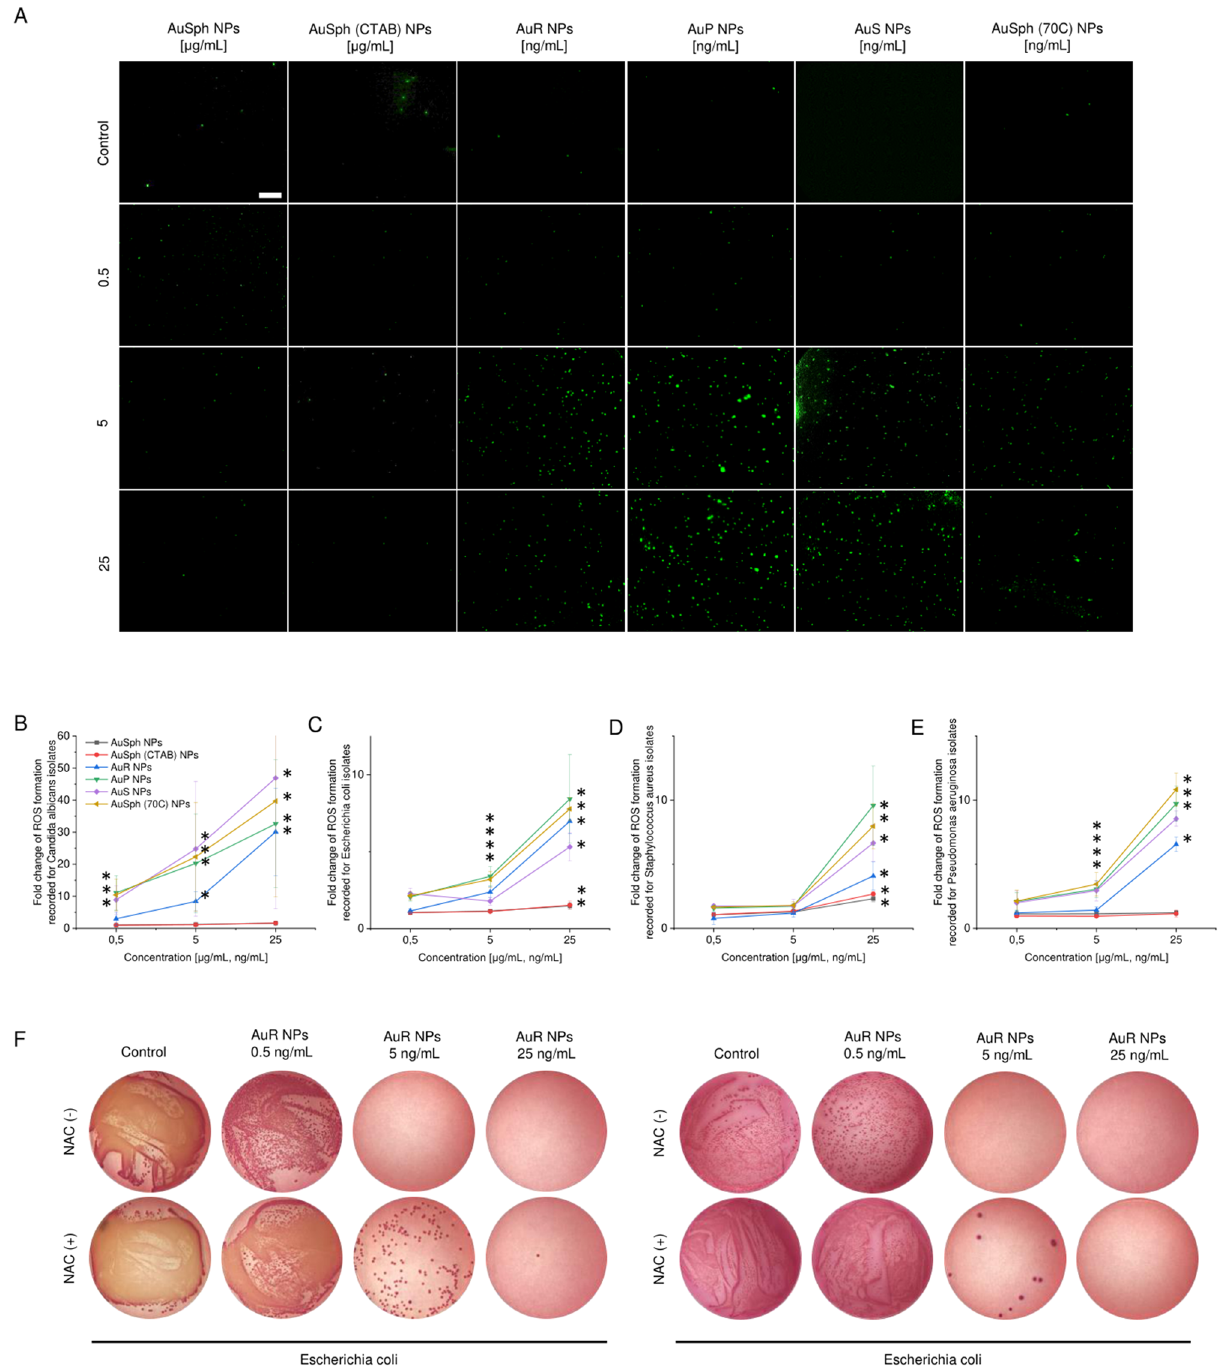
Figure 4. Generation of reactive oxygen species (ROS) in fungi and bacteria subjected to varied-shaped gold nanoparticles over an 1 h incubation. Increase of ROS-positive E. coli cells investigated using fluorescence microscopy ( A ). Scale bar ~ 20 µm. Rise in ROS-derived fluorescence signal recorded for C. albicans ( B ), E. coli ( C ), P. aeruginosa ( D ) and S. aureus isolates ( E ). Photographs of representative MacConkey agar plates with E. coli treated with AuR NPs at the indicated concentrations with or without pre-treatment with NAC for 1 h. ( F ). *Indicates statistical significance ( p < 0.05) when compared to untreated bacteria. For ( B )–( E ) results are presented as mean ± SD from 5 representative strains. For ( A ) and ( F ), the results from one representative experiment are shown. *Indicates statistical significance ( p < 0.05) when compared to untreated